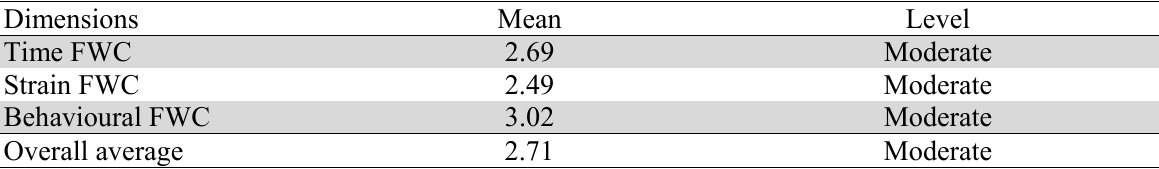
Summary of mean dimension